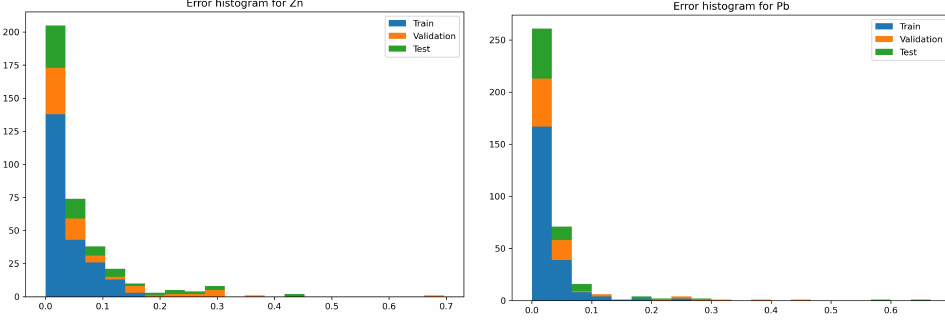
Figure 8. Histogram of mean absolute errors calculated for training, test and validation data sets for structure number 2. ( Left ) panel shows results for zinc and ( right ) panel for